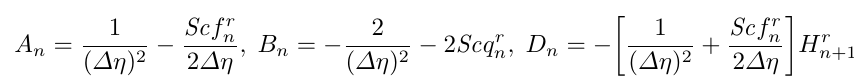
Table 1. Comparison of skin friction coefficient C f Re fluid). Ha